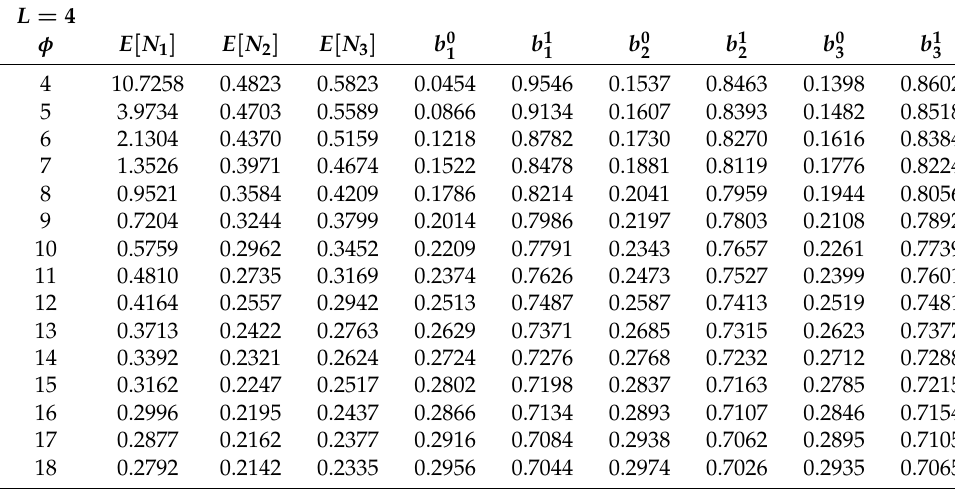
Table 8. Effect of φ on various performance measures ( L =